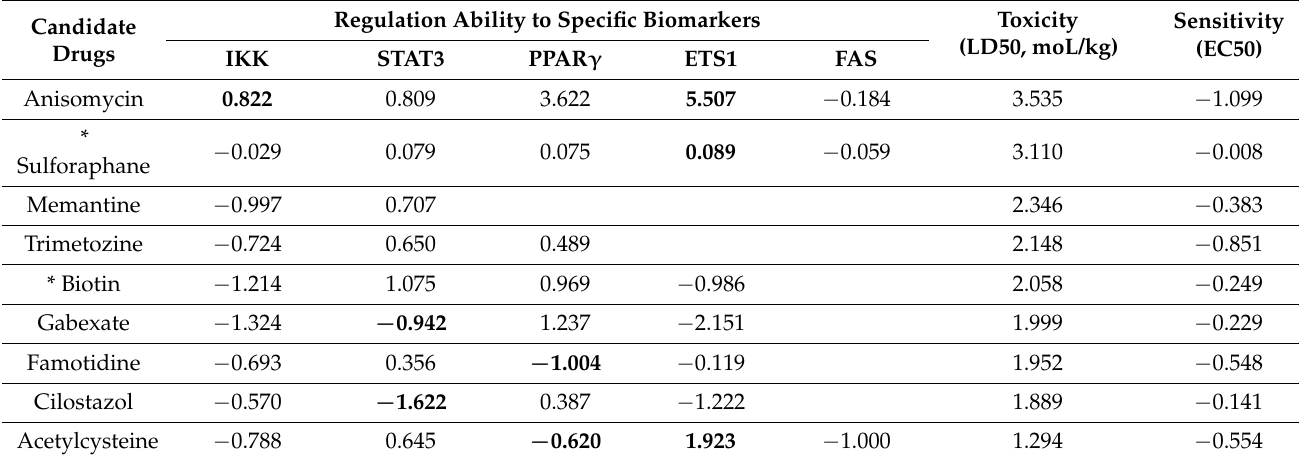
Table 6. The candidate drugs for T2D and their corresponding